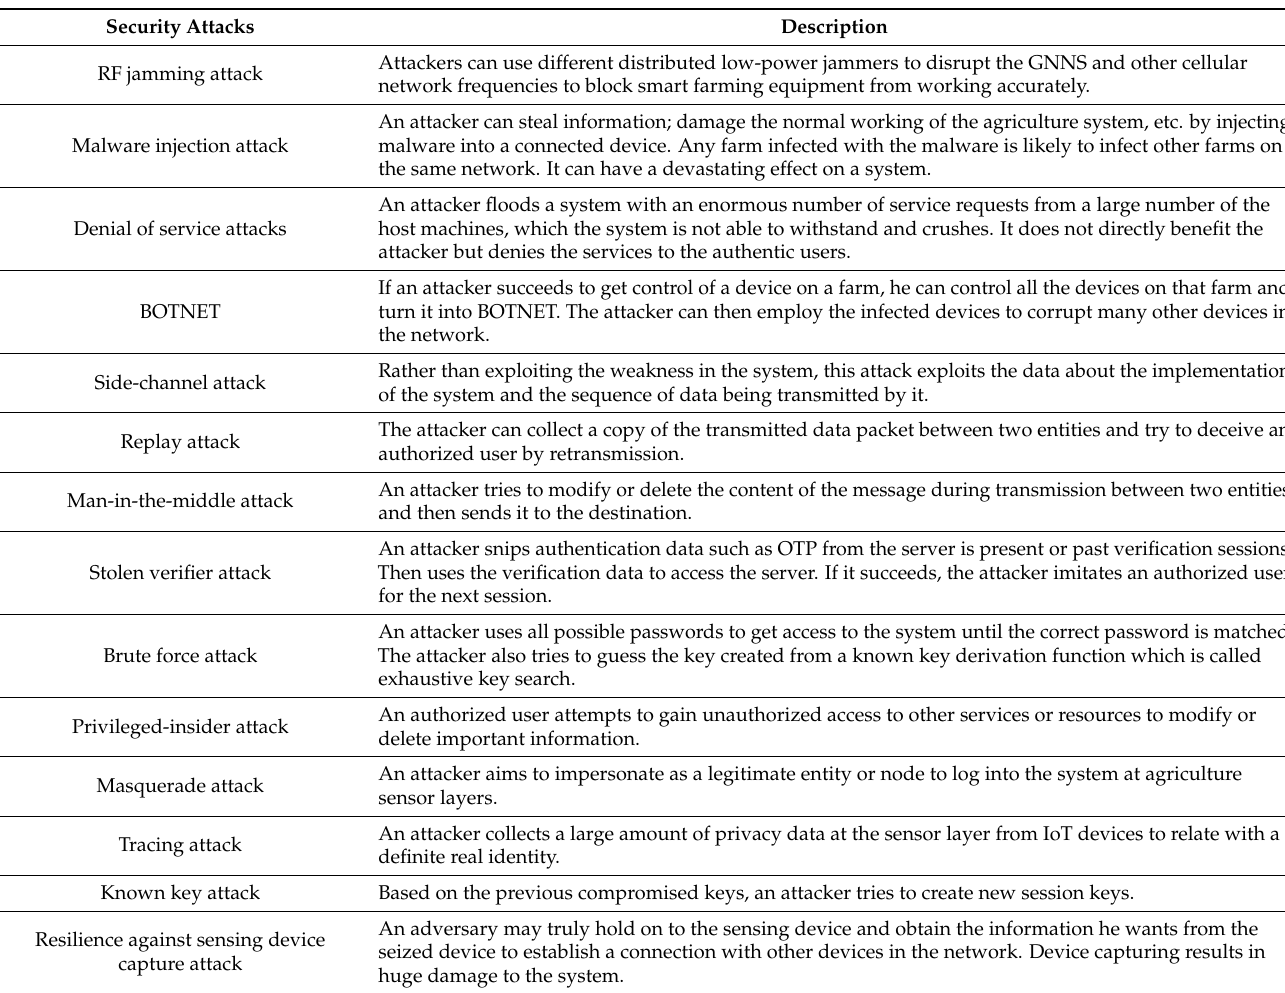
Table 2. Security Vulnerabilities in IoT-based Smart Agri-Food Supply Chain